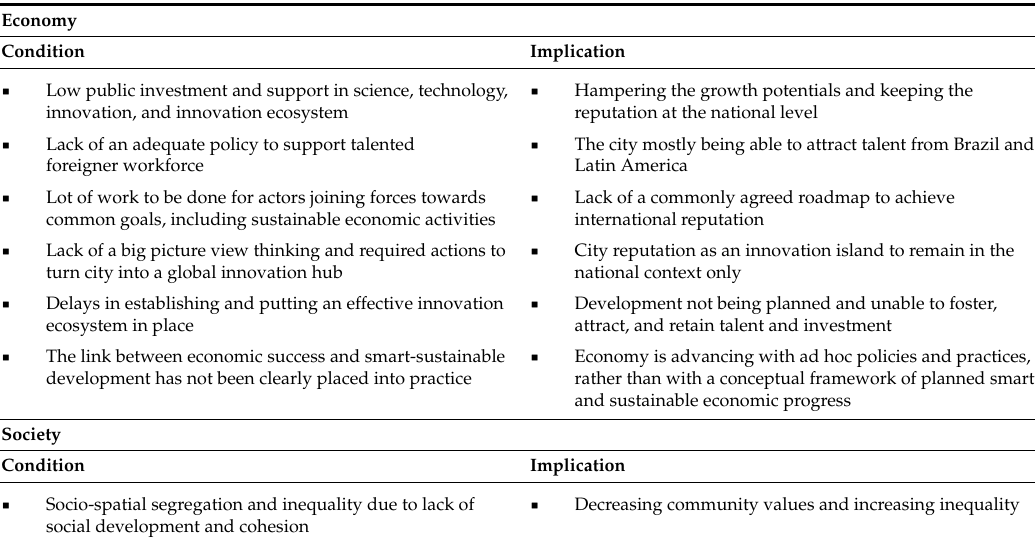
Table 4. Florianopolis’ knowledge-based urban development